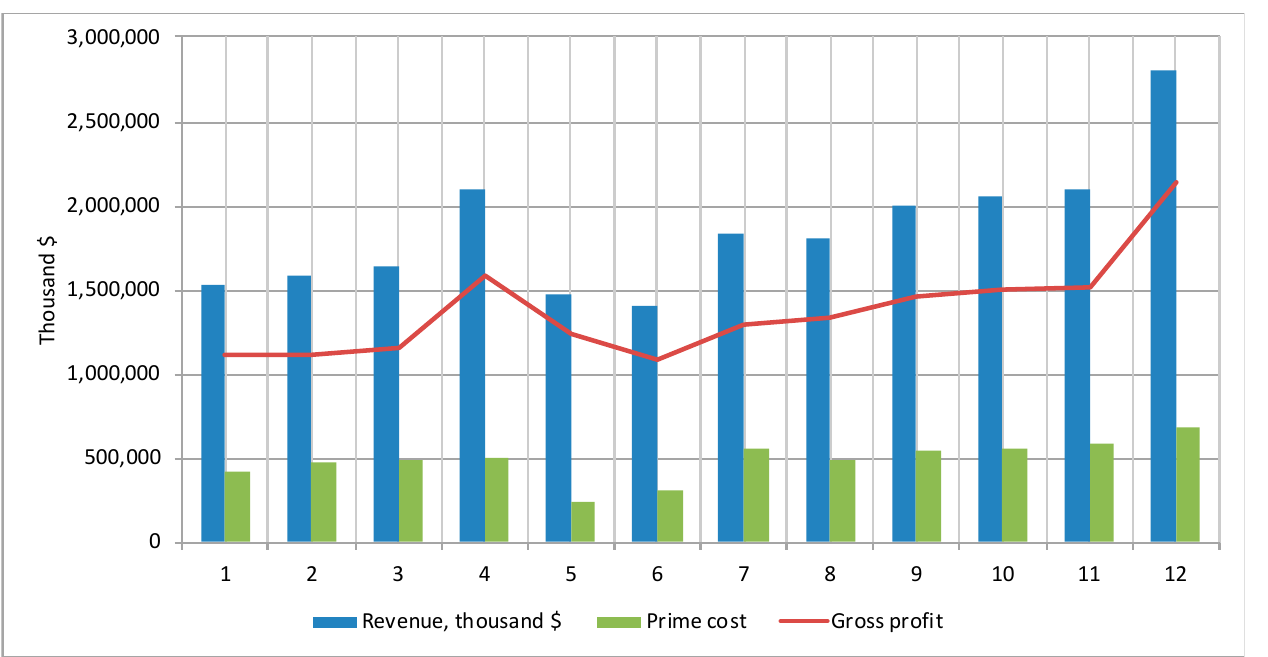
Figure 3. Forecast of the main indicators of the company’s financial activity. At that, the basic level of service is 100%, and there are no interruptions in replenishing and timely customer orders. The second simulation experiment was carried out for the case of a 100% probability of occurrence of both risk events: a fire in the DC and a failure in dairy production (P = 1). The results of modeling financial indicators for this scenario are shown in Figure 4.